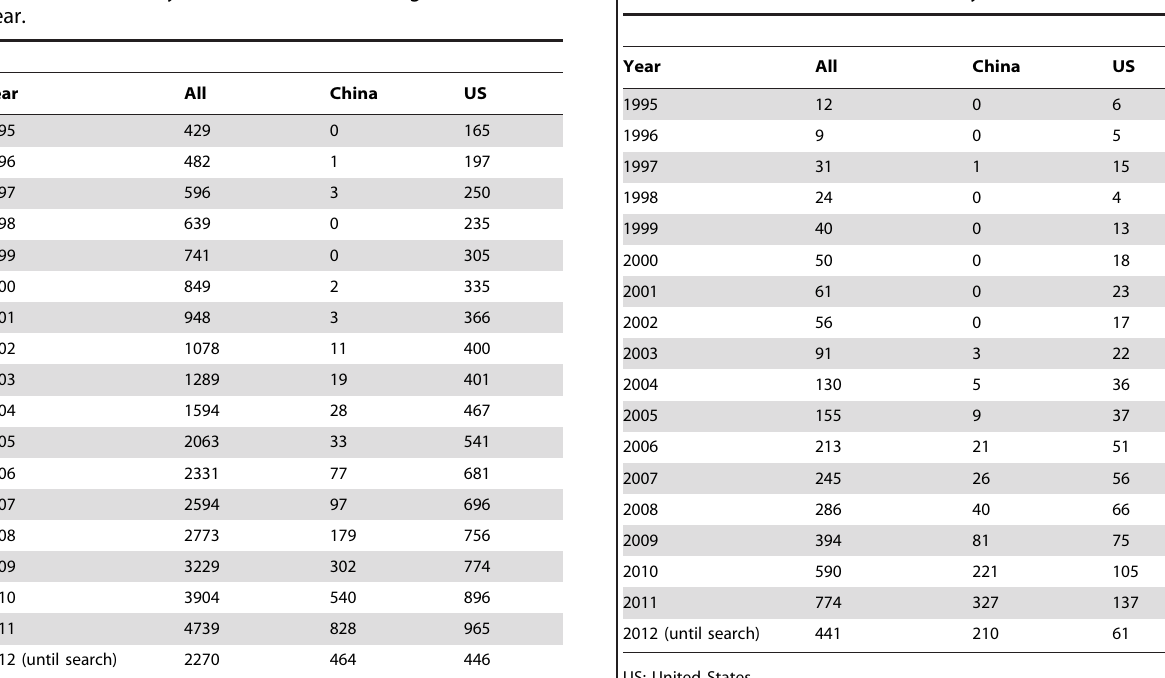
Table 1. Meta-analyses in PubMed According to Publication